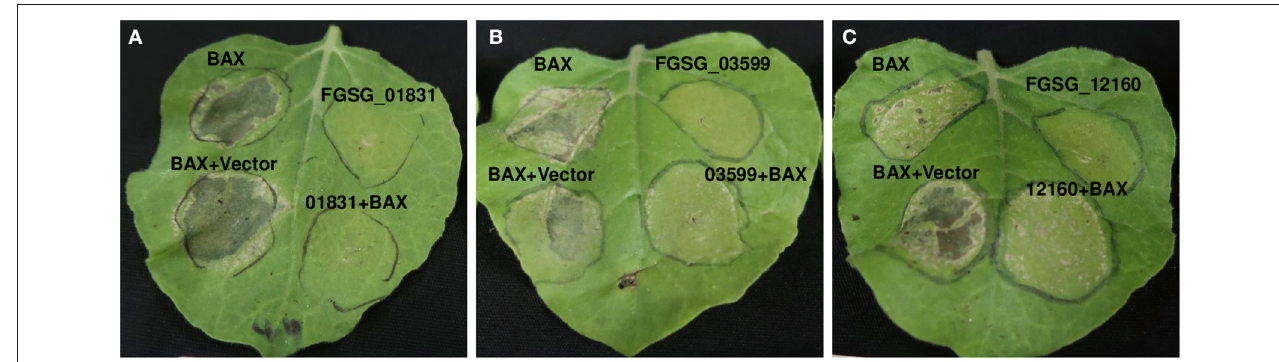
FIGURE 7 | Suppression of Bax-induced cell death by F. graminearum effectors. (A) FGSG_01831, (B) FGSG_03599 and (C) FGSG_12160 Agrobacterium strain GV2260 carrying Bax was co-infiltrated in N. benthamiana leaves with each GV2260 strain carrying a F. graminearum effector or an empty vector. Each A. tumefaciens strain containing Bax, the respective effector gene, or an empty vector control was adjusted to OD 600 = 1.0 then mixed in equal volumes. Cell death induced by Bax was visualized and imaged 5 days after infiltration. Six leaves from two plants for each effector were infiltrated. Three independent experiments were performed, and similar results were